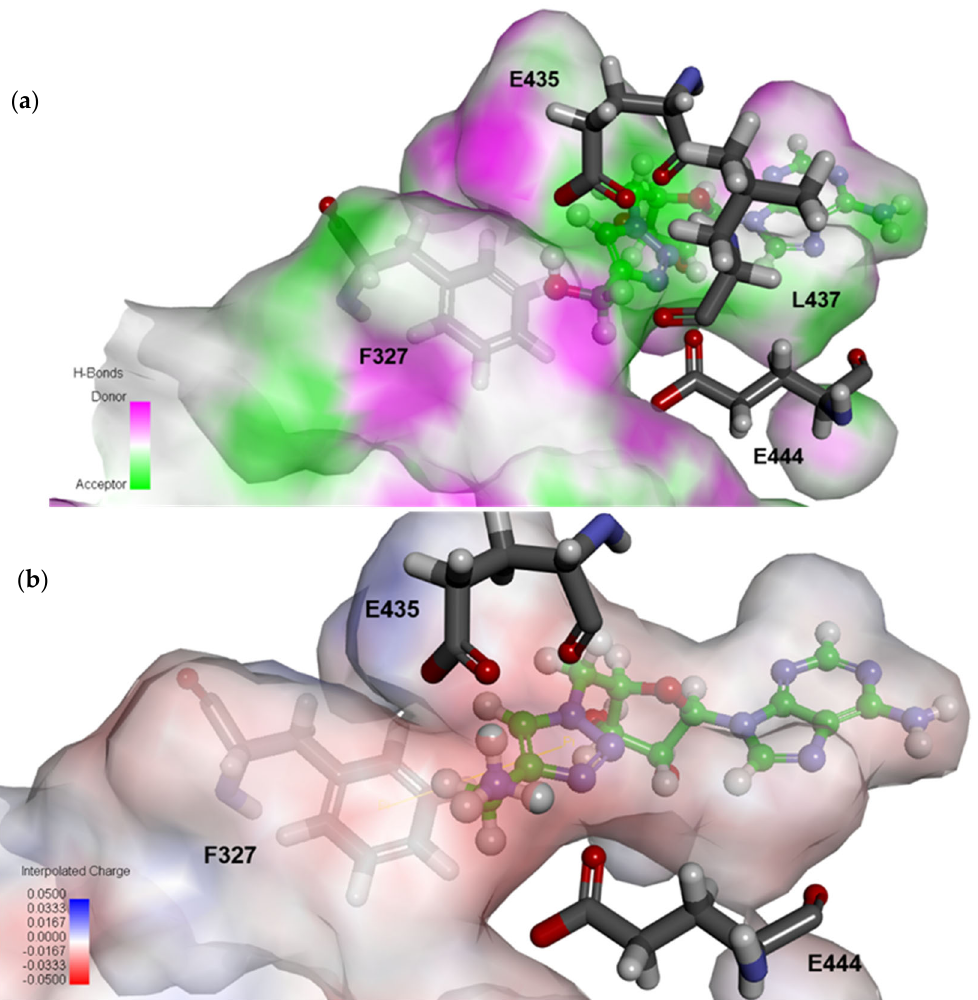
Figure 5. ( a ) The docked pose of 3 places the hydroxyl group in the arginine ‐ binding pocket, where it is able to accomplish extensive hydrogen ‐ bonding interactions. ( b ) Docked pose of 6 with the triazole portion occupying the substrate arginine ‐ binding pocket places the positively charged substituent in a negatively charged pocket of the enzyme.